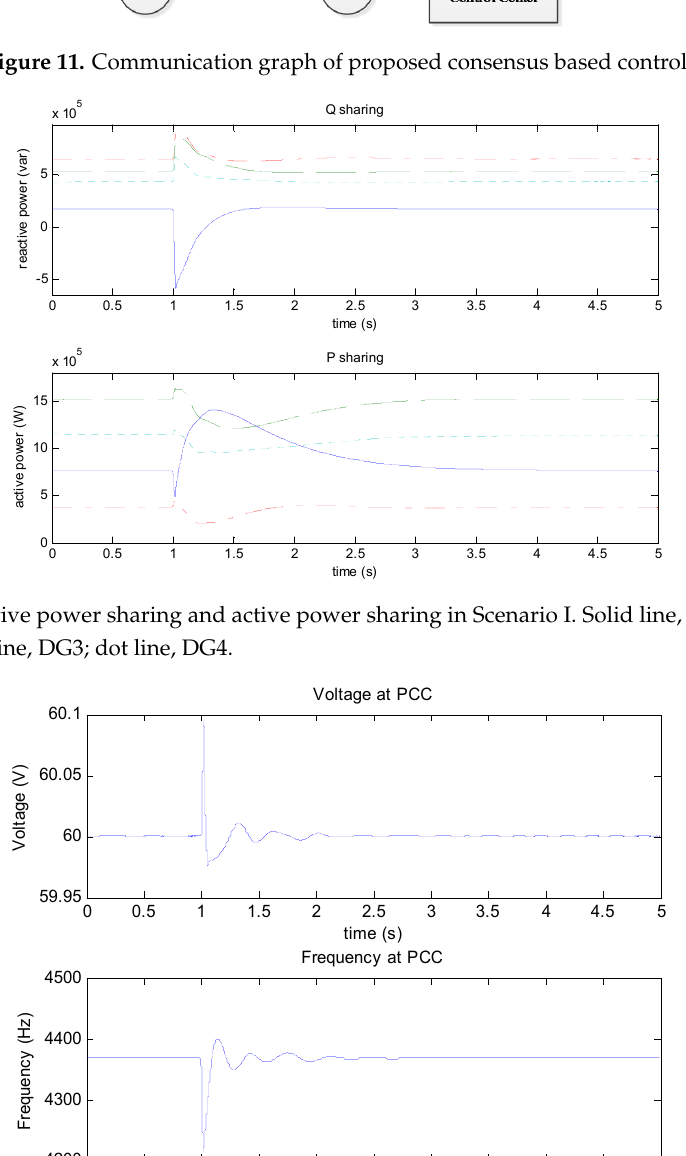
Figure 13. PCC voltage and frequency in Scenario I.